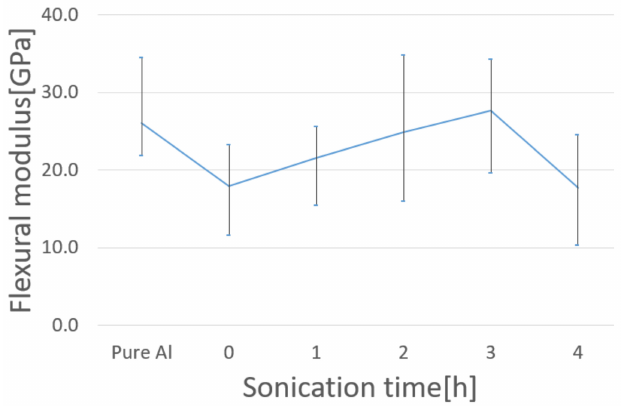
Figure 9. Flexural modulus as a function of sonication time for Al and 0.5 mass.% CNT / Al composites.